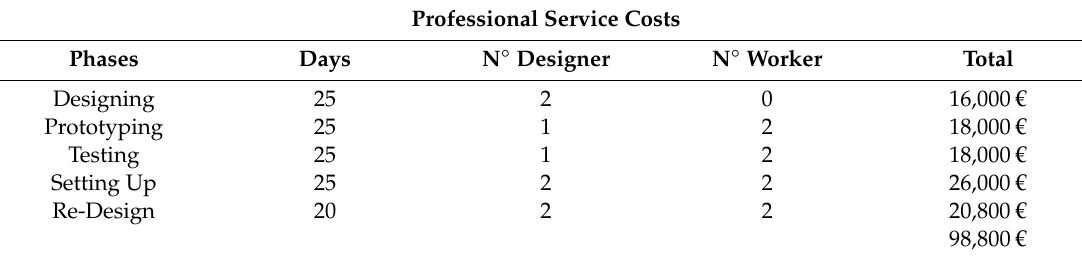
Table 6. Professional Service